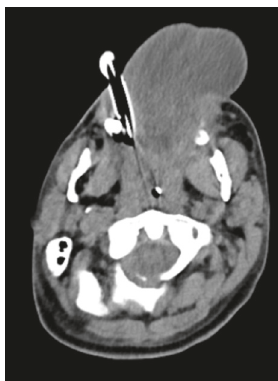
Figure 2: Axial cross section of a soft-tissue window computed tomography image with a tongue protrusion and endotracheal tube in place.